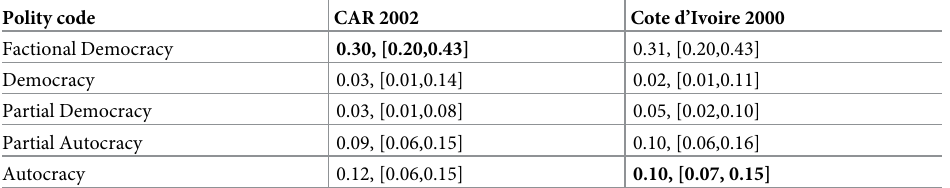
Table 6. Counterfactuals. Actual prediction (bold) versus counterfactual predictions for different polity codes with 95% CI for CAR and Cote d’Ivoire, two-year event